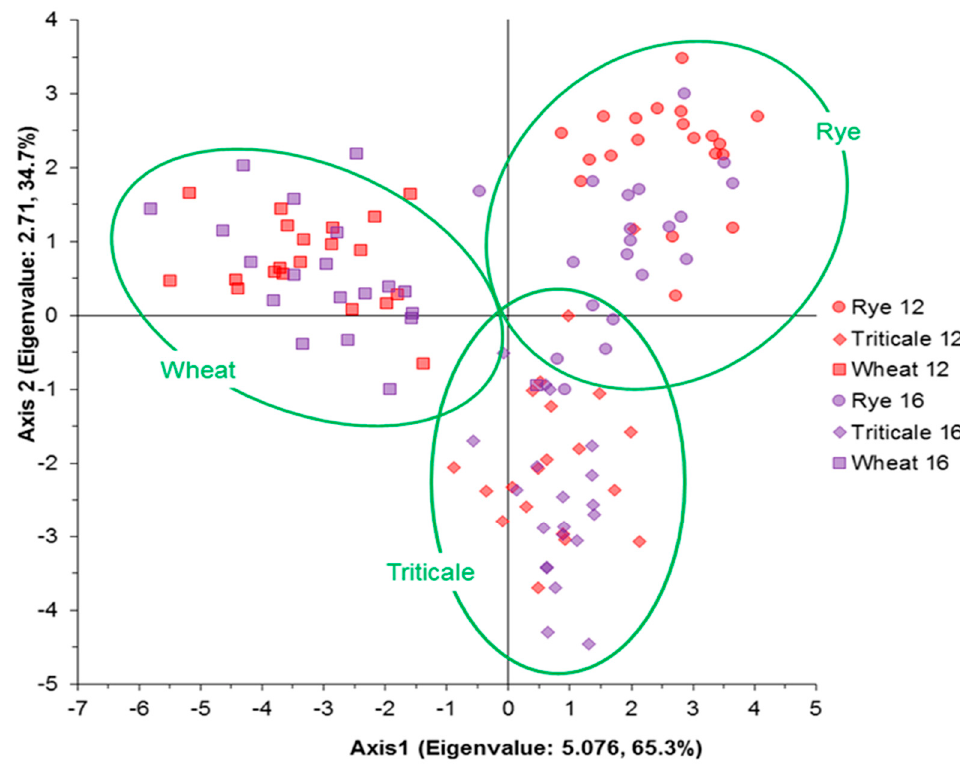
Figure 7. Discriminant analysis grouping different cereal types at two moisture contents (12% and 16%).